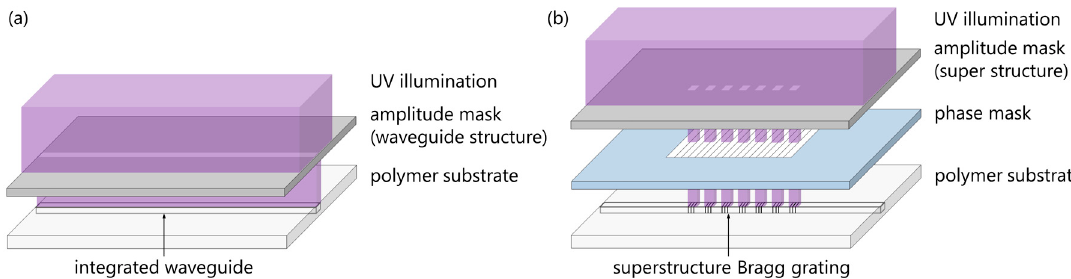
Figure 3. Schematic illustration of the setup (vertically exploded assembly drawing) for the fabrication of superstructure Bragg gratings by successively writing ( a ) an integrated waveguide and ( b ) a superstructure Bragg grating (masks and polymer substrate are in contact).